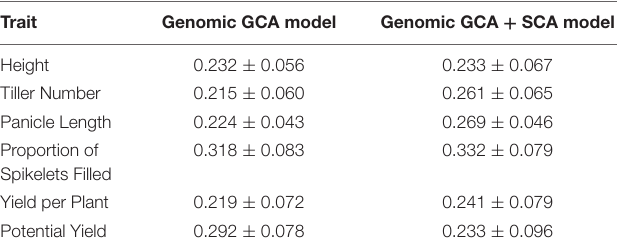
TABLE 8 | Mean, standard deviation, and range of relative yield per plant of the F 1 hybrids compared to each inbred